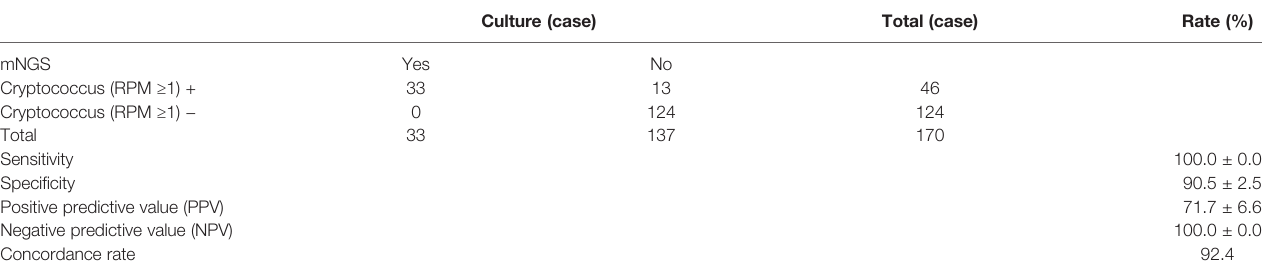
TABLE 3 | The performance of mNGS against the “ gold standard ” culture method.